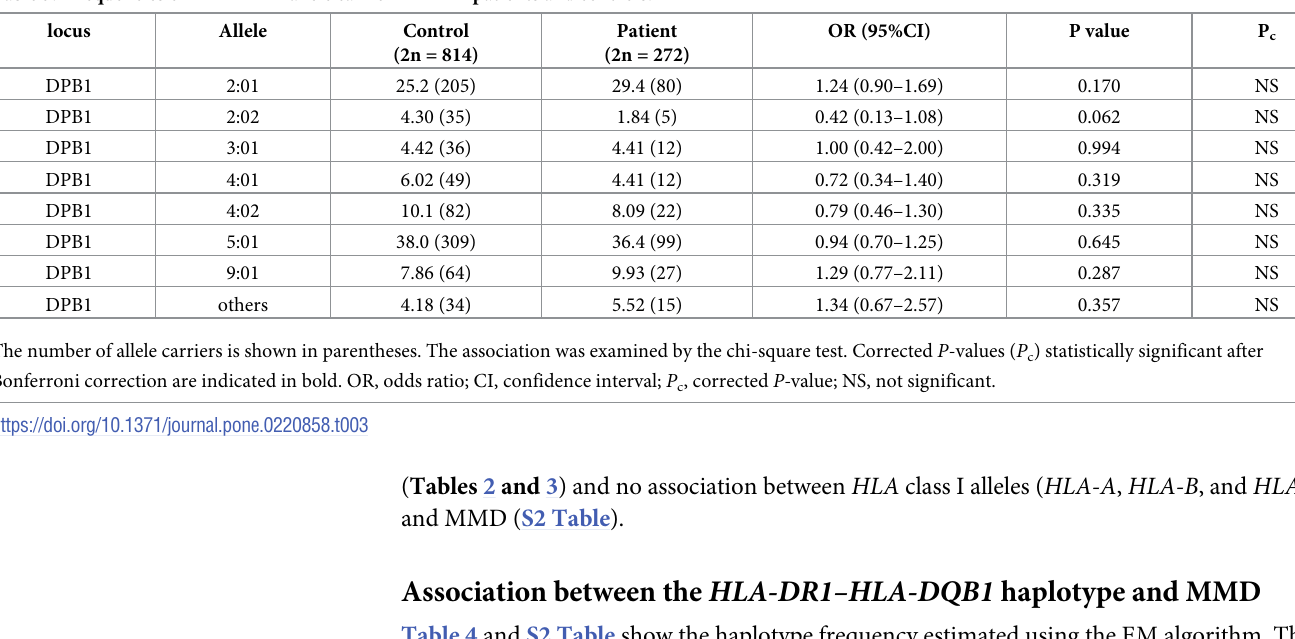
Table 4 and S2 Table show the haplotype frequency estimated using the EM algorithm. The